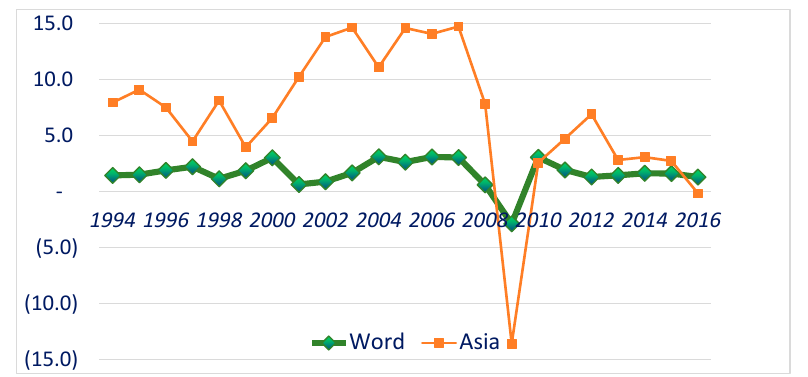
Figure 1. Average growth rate of GDP per capita of World and Asian countries in 1994–2016.